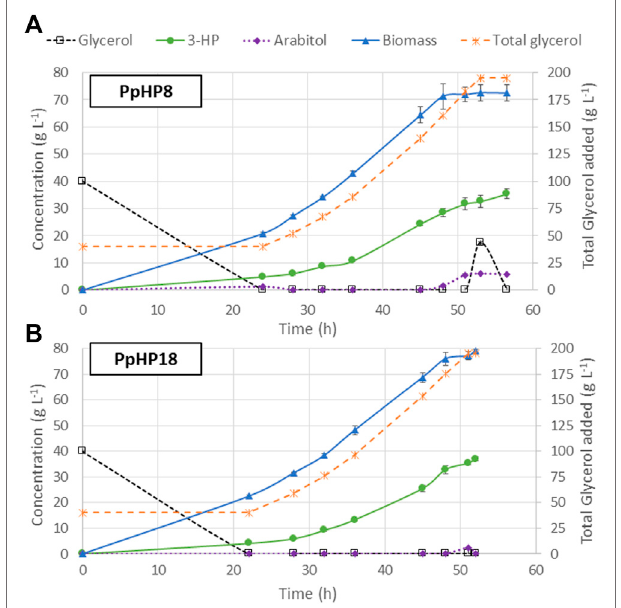
FIGURE 4 | Pro fi les of fed-batch cultivations of the PpHP8 (A) and PpHP18 (B) strains. Concentration ofglycerol,biomass, 3-HP, and D-arabitol are represented using the left-side y -axis. The total amount of glycerol added to the reactor, normalized by the actual volume of the reactor at every timeis represented using the y -axis at the right side. The average result oftwo independent cultivations is shown. The error bars correspond to the standard deviation for the